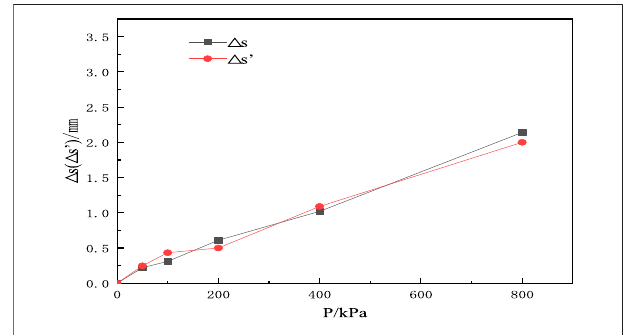
FIGURE 9 | Relation between Δ s ( Δ s ′ ) and